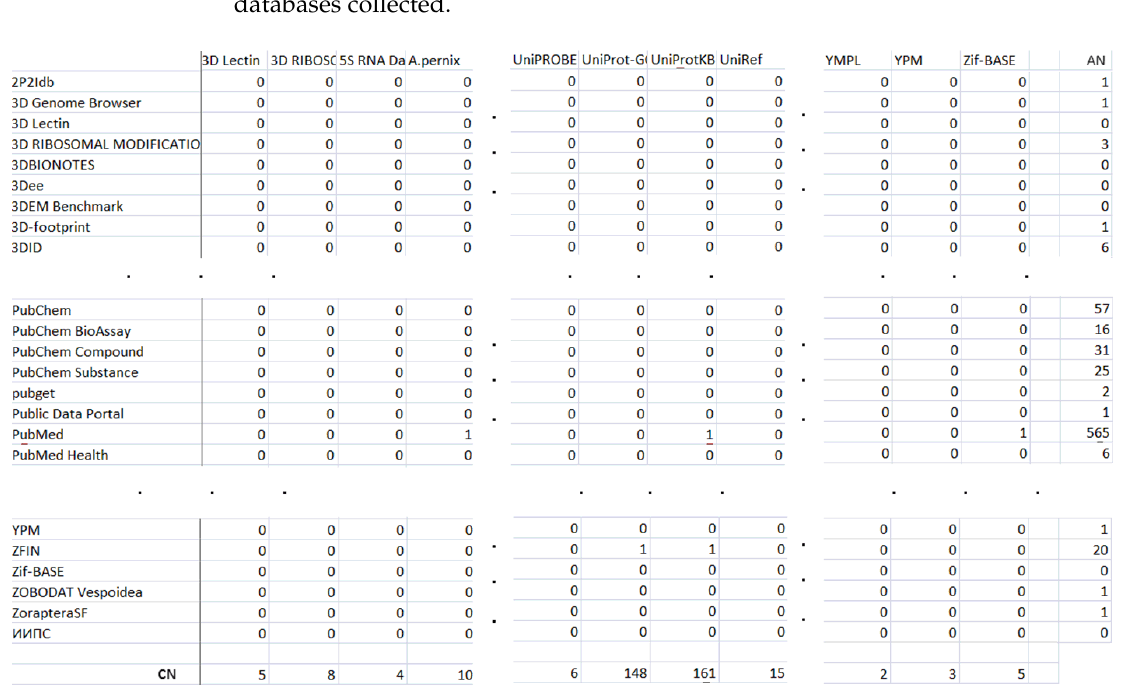
Figure 3. Example of database interconnection. DBGET materials (Japan).